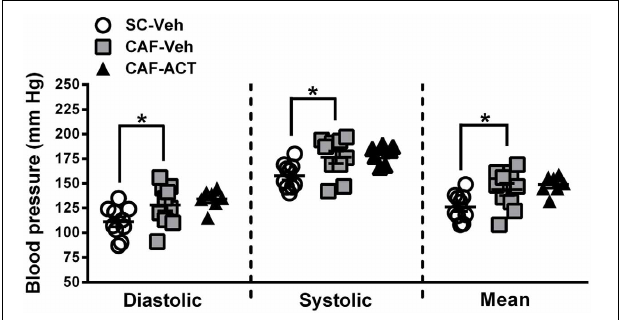
FIGURE 6 | Blood pressure in week 17. Diastolic, systolic, and mean blood pressures of SC or CAF diet fed rats treated with Veh or ACT. Horizontal bars represent the mean ± s.e.m. ( n = 7–10) per group. Reliable data was not attainable from 1 CAF-Veh rat and from 2 CAF-ACT rats, and were therefore omitted from analyses. ∗ p < 0 . 05 by t -test. No statistical difference was revealed between the CAF-ACT and the CAF-Veh group. ( SC , standard chow; CAF , cafeteria diet; Veh , vehicle; ACT ,